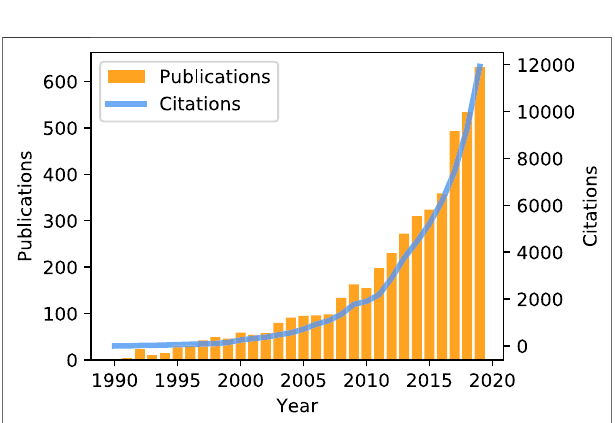
FIGURE 2 | Evolution of the number of scienti fi c publications about optimal control in buildings during the last decades. Data obtained from the Clarivate Web of Science